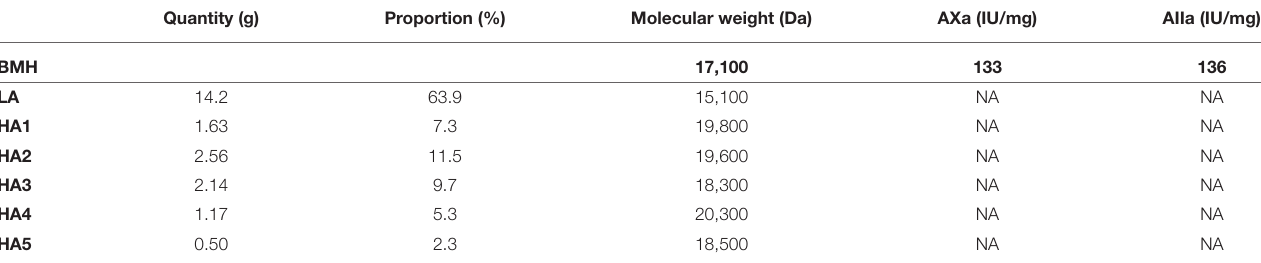
TABLE 3 | Characteristics of bovine mucosal heparin (BMH, starting heparin) and observed ATIII affinity chromatography fractions, with proportions. Quantity (g) Proportion (%) Molecular weight (Da) AXa (IU/mg) AIIa (IU/mg)